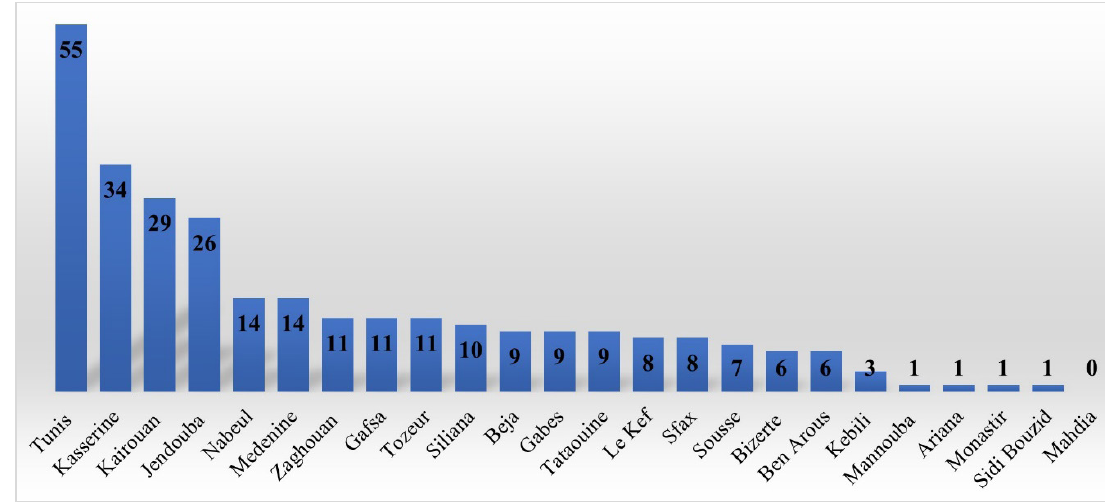
Fig 3. Apidae species number per province in